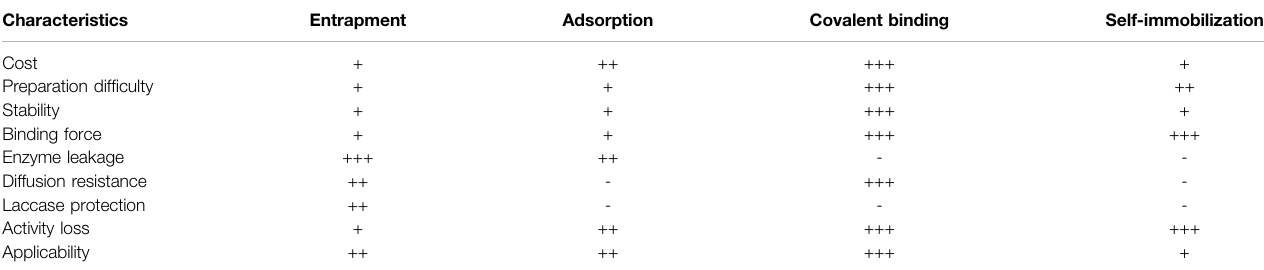
TABLE 2 | Inherent characteristics of immobilization methods (Zhou et al., 2021). Characteristics